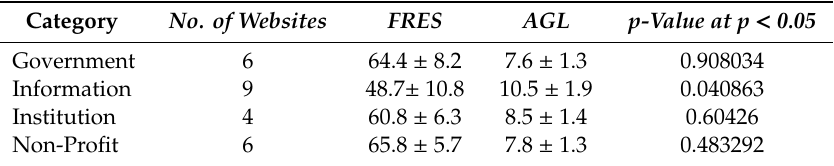
Table 7. Average Readability score of all categories of